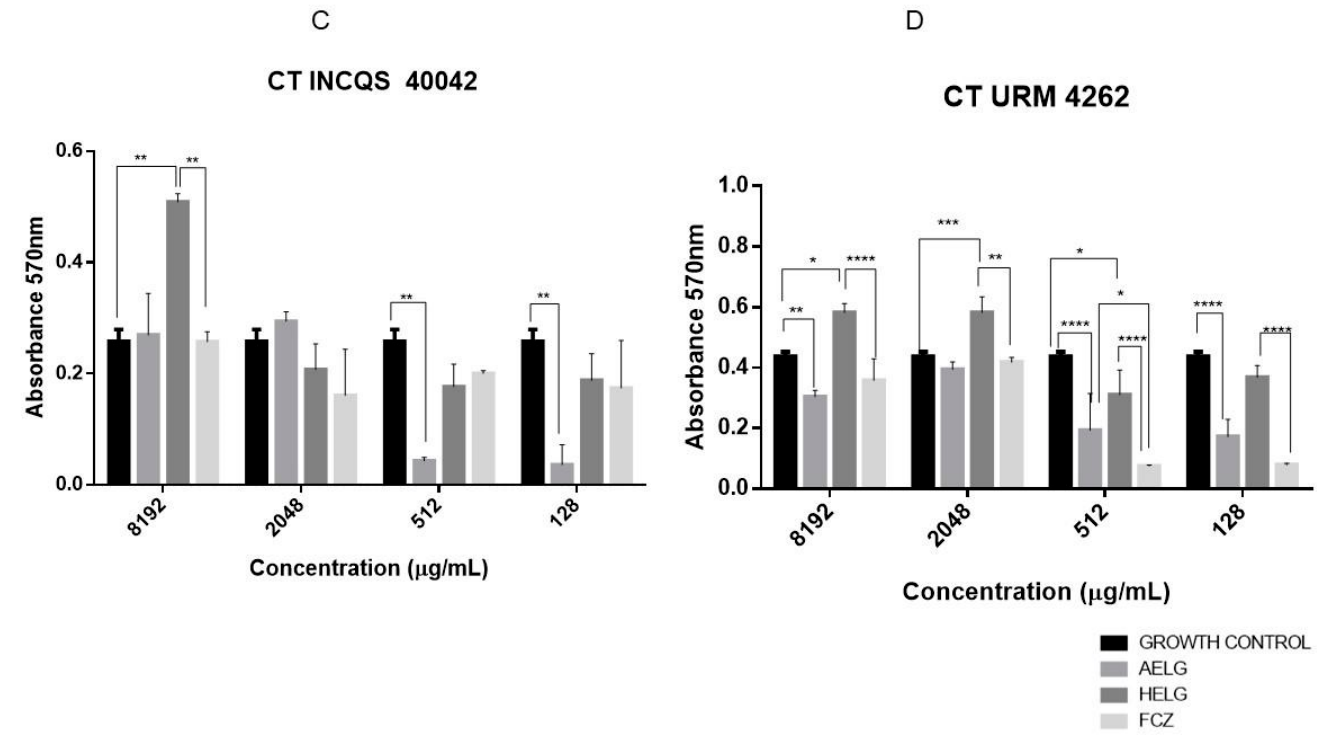
Figure 5. Effects of G. hirsutum extracts and fluconazole against Candida albicans INCQS 40006 ( A ), Candida albicans URM 4387 ( B ), Candida tropicalis INCQS 40042 ( C ) and Candida tropicalis URM 4262 ( D ). Statistical significance was determined considering the difference in relation to growth control/fluconazole. **** = p < 0.0001; *** = p < 0.001; ** = p < 0.01; * = p < 0.1. AELG—Aqueous extract of the leaves of G. hirsutum . HELG—Hydroethanolic extract of the leaves of G. hirsutum